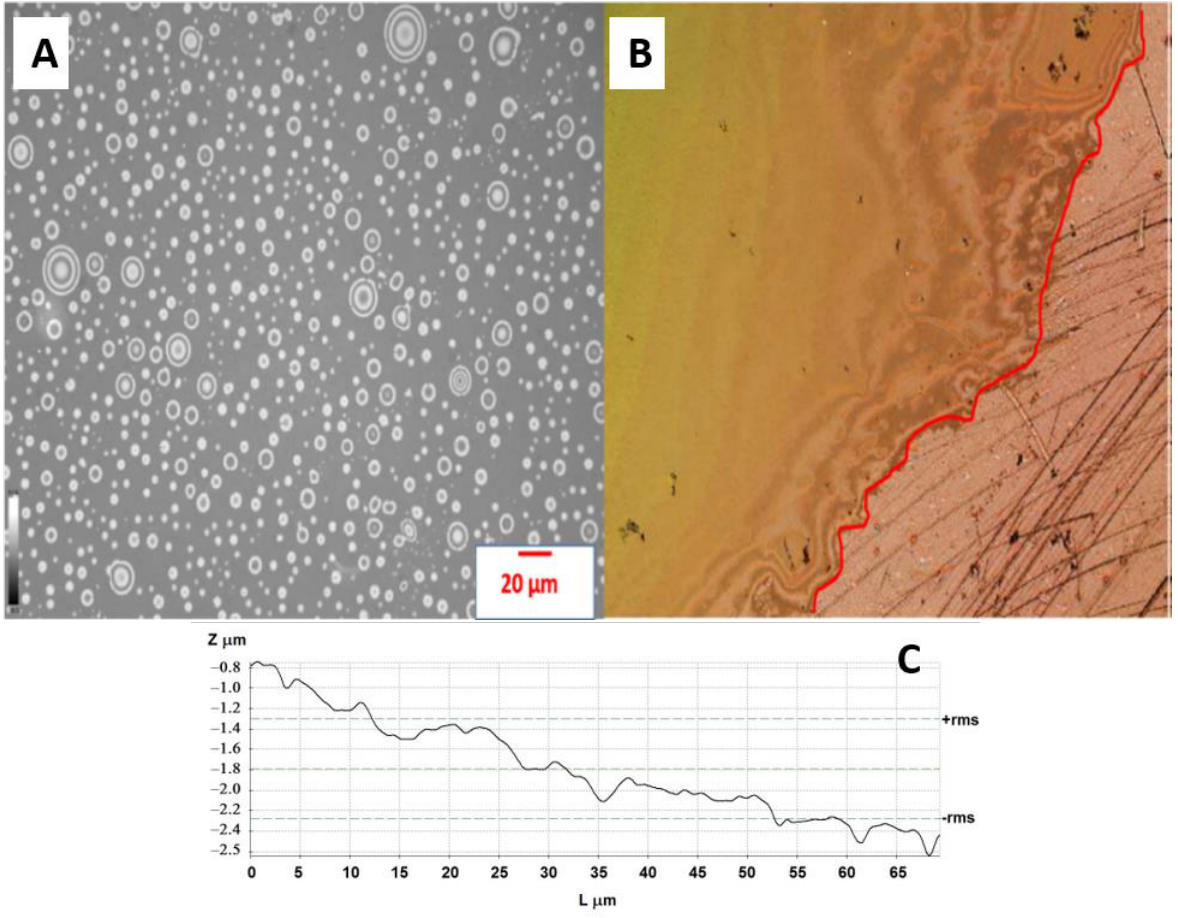
Figure 3. ( A ) The distribution of droplets of emulsion on the surface of treated PE foil; ( B ) Thin layer of DO deposited onto the surface of treated PE foil. The red line denotes the interface between the area covered by DO and the reference (non-immersed part of the foil); ( C ) Line profile for the surface of the treated PE foil.